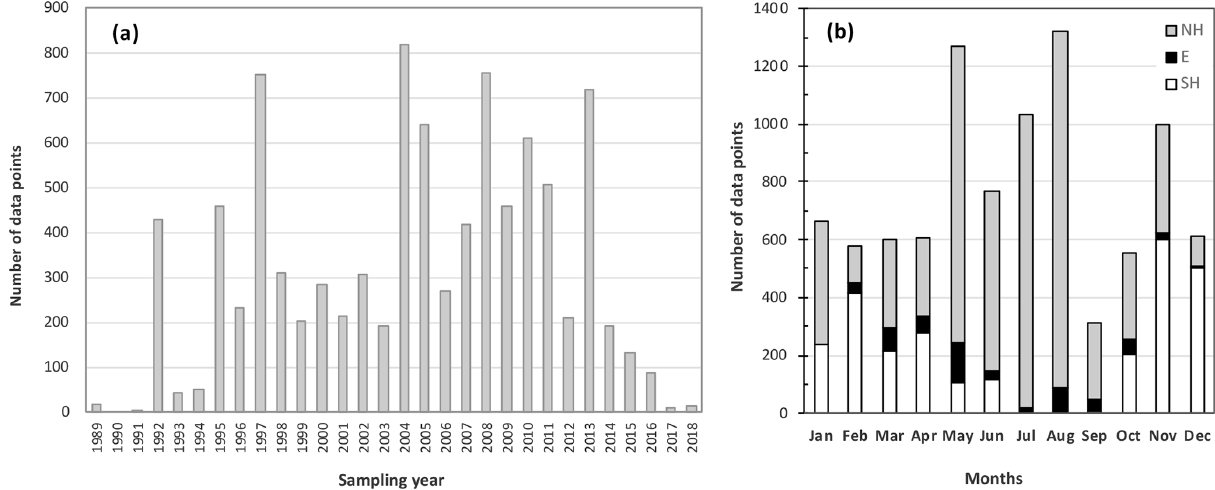
Figure 3. (a) Histogram of data sampled between 1989 and 2018. See Table 1 for details. (b) Number of samples per month of the year grouped as per sample collected in the Northern Hemisphere (NH; grey), in the Southern Hemisphere (SH; white), or at the Equator (E; − 10 to 10 ◦ N; black).